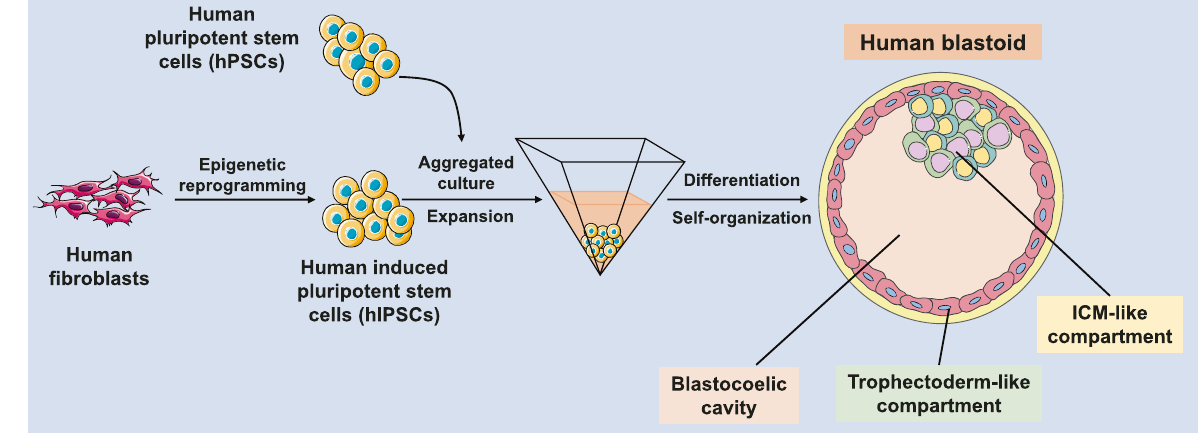
Fig. 1 Schematic procedure for the human blastoid generation from human